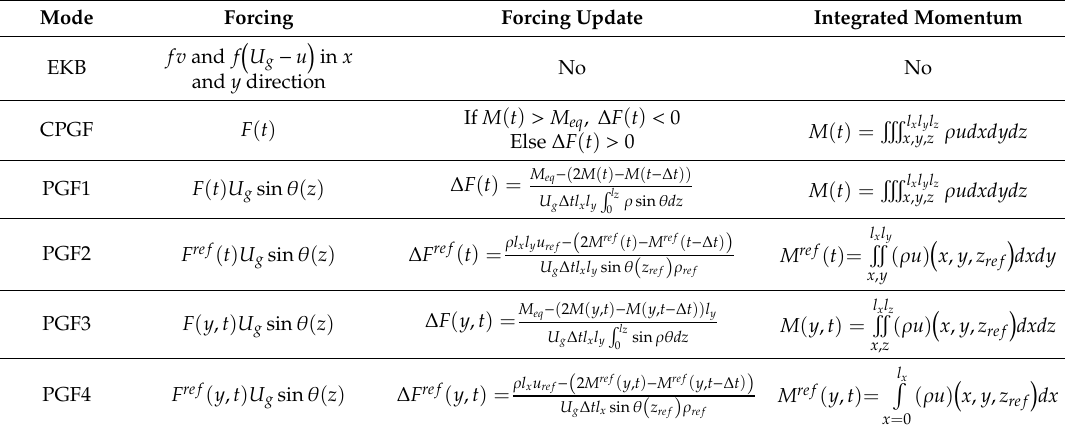
Table 1. Description of the di ff erent forcing corresponding to a geostrophic wind U g vector of the x -axis). z ref is the reference height where velocity u ref is targeted, ρ ref is air density at z ref , sin θ is defined according to Equation (9) and l x , l y , l z are the extents of the domain along the x , y and z -axes. Except for the Ekman balance (EKB), the forcing (CPGF or PGFs) is applied to the u-momentum equation